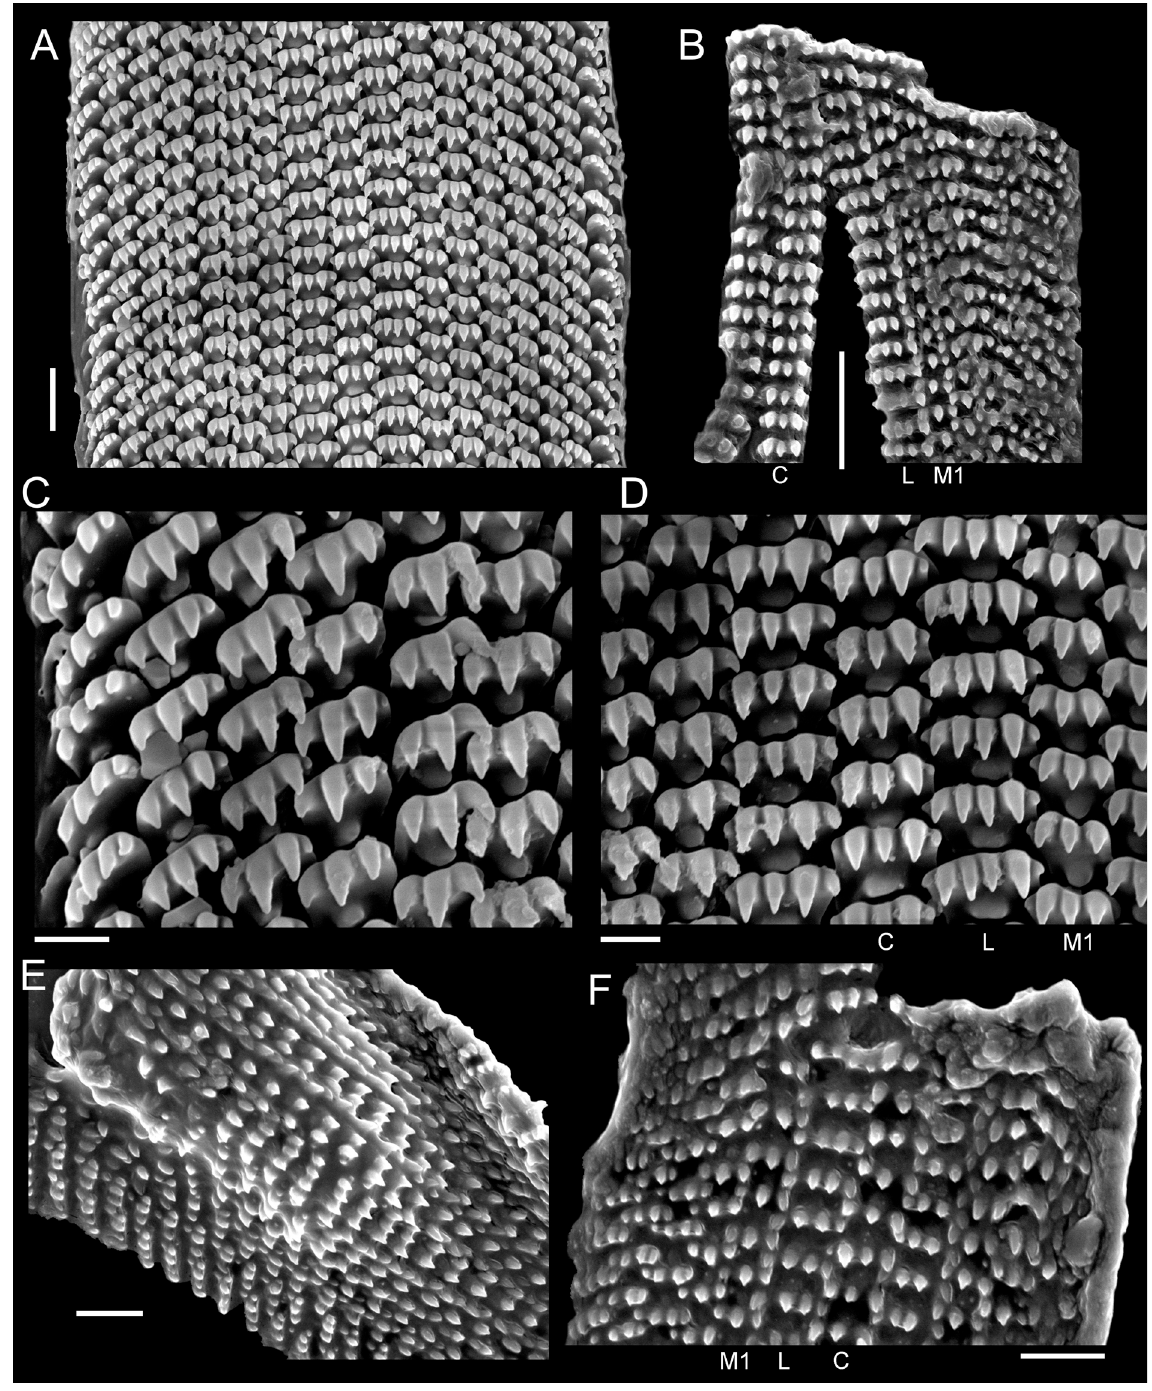
Fig. 20. Nanaphora verbernei (Moolenbeek & Faber, 1989), radula. A–D . MNRJ 28956. E–F . MZSP 85022. Scale bars: A, E–F = 5 µm; B = 10 µm; C–D = 2